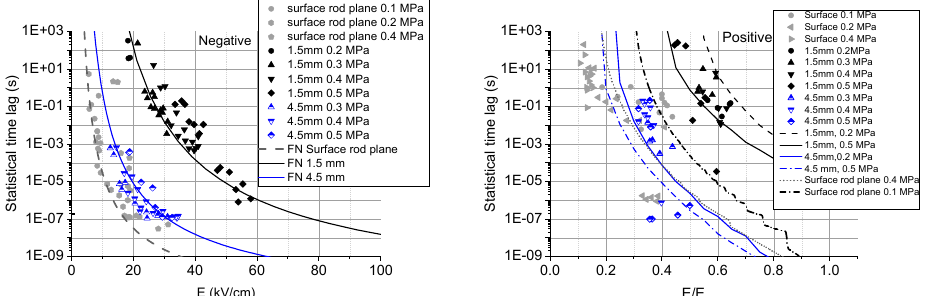
Figure 5. Statistical time lags in CO 2 at negative ( left ) and positive ( right ) polarity vs. background electric field for technical surface roughness and protrusions with 1.5 and 4.5 mm lengths. The curves are the model predictions and the symbols result from measurements given in [37]. For the technical surface roughness estimates, a 20- µ m hemispherical protrusion on the surface was assumed [36]. Note that, for positive polarity, the electric field is normalized to the critical field E cr , which yields a less scattered representation for the different pressures used.